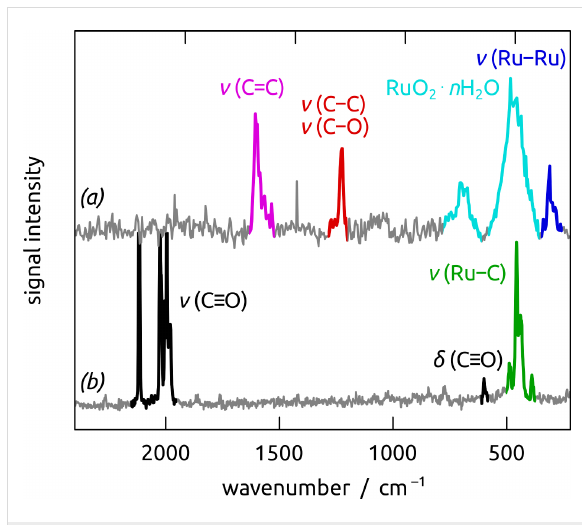
Figure 7: Raman spectra of a nanostructured template coated with Ru/C films, without ITO contact (a) and of the solid precursor Ru 3 (CO) 12